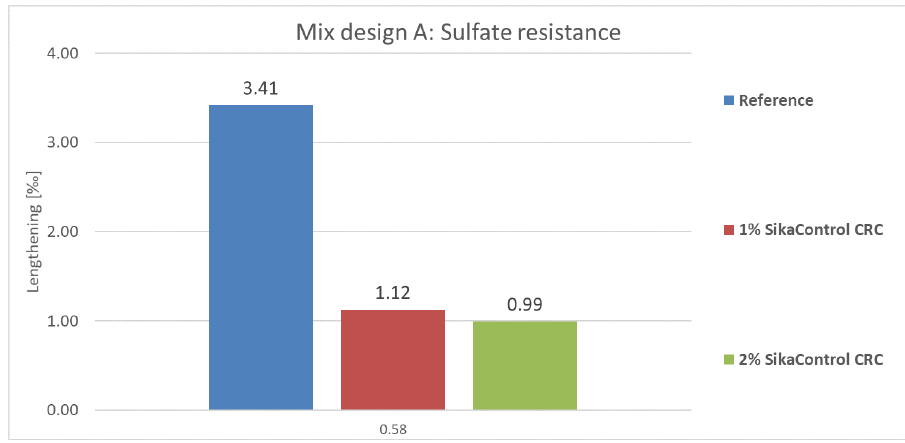
Figure 1. Mix design A: Sulfate resistance.